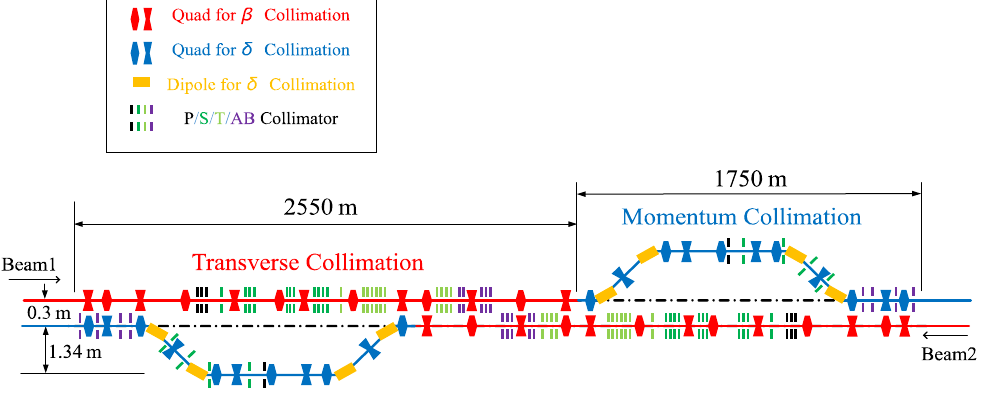
FIG. 4. Layout of the collimation insertion. P , S , T , and AB denote the primary collimator, secondary collimator, tertiary collimator, and absorber,